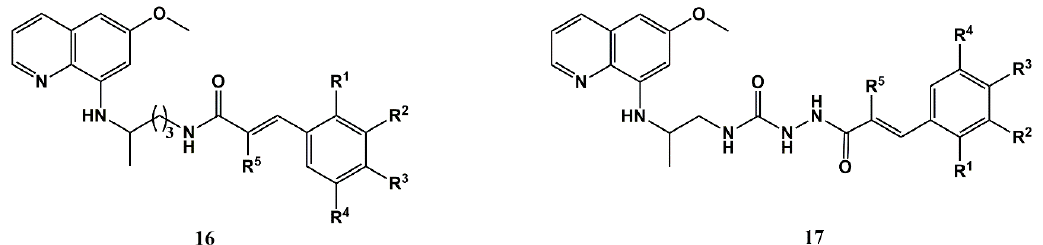
Figure 7. Antiproliferative primaquine-CA conjugates developed by Zorc et al. [74,75]. Building on the antiproliferative activity of the antimalarial drug artemisinin ( 5 ) and its derivatives [76,77], Xu et al. have synthesized dihydroartemisinin-CA conjugates 18 and 19 (Figure 8), and evaluated their activity against one normal (L-02) and four cancer (PC-3, SGC-7901, A549, and MDA-MB-435) cell lines. One of the conjugates ( 19 , where R 1 = R 4 = R 5 = H, and R 2 = R 3 = OMe) was found to have strong and selective activity against the lung cancer cell line A549 (GI 50 = 0.20 µ M), likely associated with the compound’s ability to induce increased levels of intracellular ferrous ions, and oxidative stress leading to apoptosis [78].